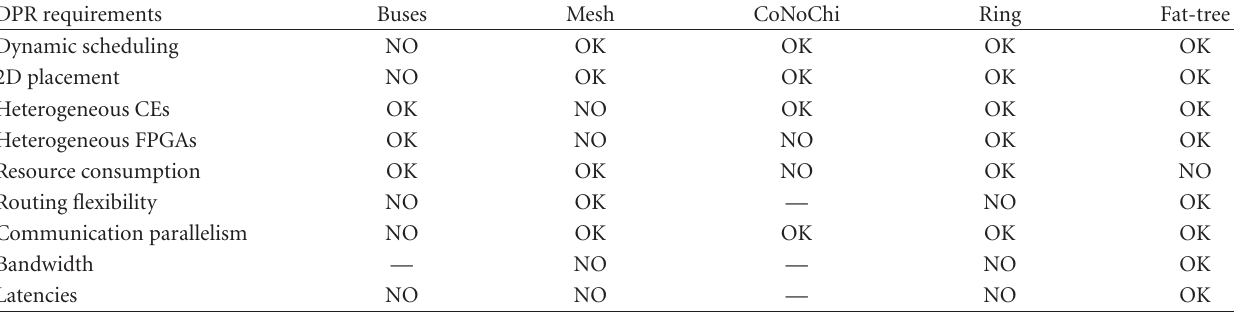
Table 1: Compliance between current interconnection structures and DPR constraints.